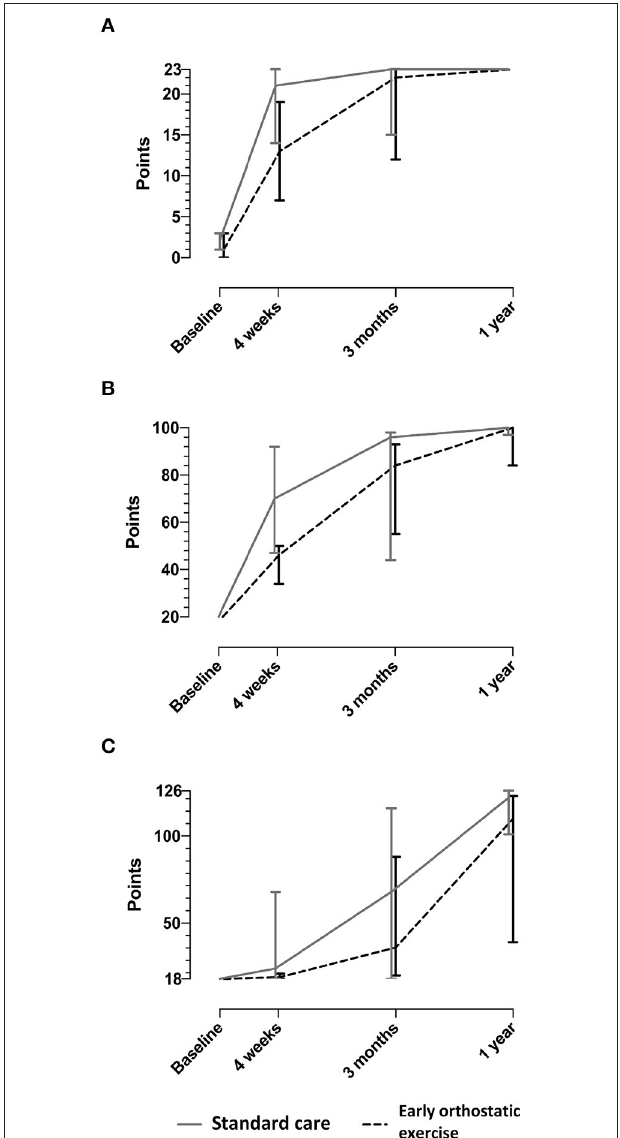
FIGURE 2 | Exploratory outcomes. The figure displays the median score with interquartile ranges. Raw data are presented in Supplementary Table 1